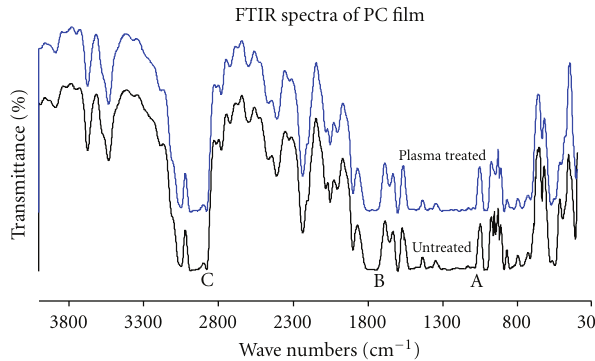
Figure 4: FTIR spectra of untreated and treated PC film.